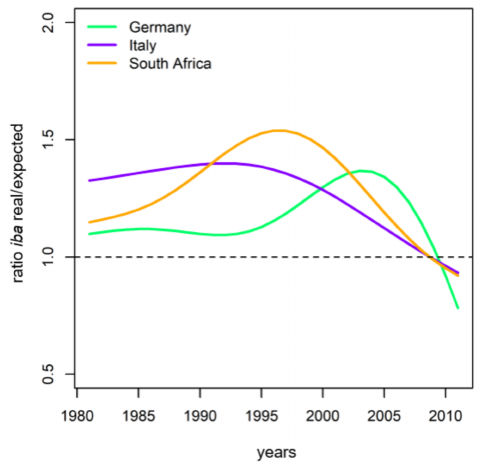
Figure 5. Individual tree basal area growth over tree size for the period before 1980 (solid line) and after 1980 (dotted line). Study sites: ( a ) Germany, ( b ) Italy, and ( c ) South Africa.